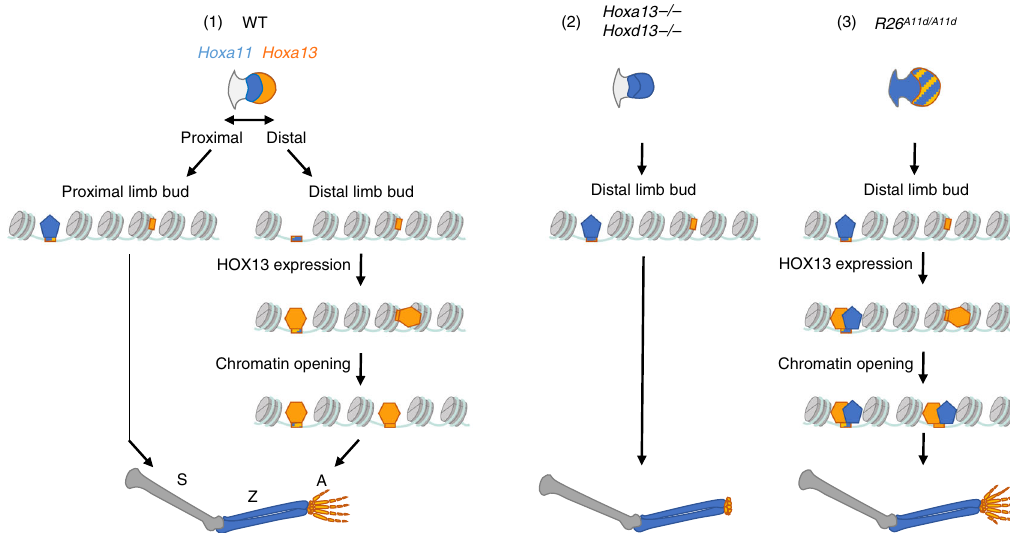
Fig. 4 Model of the role of HOX13 in chromatin accessibility in the transition from proximal to distal limb. In wild-type limb buds (left), HOXA11 (blue pentagons) is expressed in the proximal domain, whereas HOX13 factors (orange hexagons) are expressed in the distal domain. HOX13 TFs bind target loci irrespective of their chromatin accessibility, such that targets in a “ closed ” conformation switch to an accessible state. This change in chromatin accessibility does not occur in Hox13 null limb buds (middle), resulting in the loss of the distal-speci fi c chromatin accessibility landscape and disrupting the distal limb developmental program. In the R26 A11d/A11d mutant limb buds (right), HOXA11 is expressed in the distal limb domain (HOX13 domain) where its target repertoire expands to loci made accessible by HOX13. Such ectopic binding of HOXA11 at sites that are HOX13-speci fi c in the wild-type context correlates with the formation of additional digits in the R26 A11d/A11d limbs. In absence of HOX13, HOXA11 is ectopically expressed in the distal bud but is unable to bind the distal-speci fi c sites in a non-accessible chromatin state